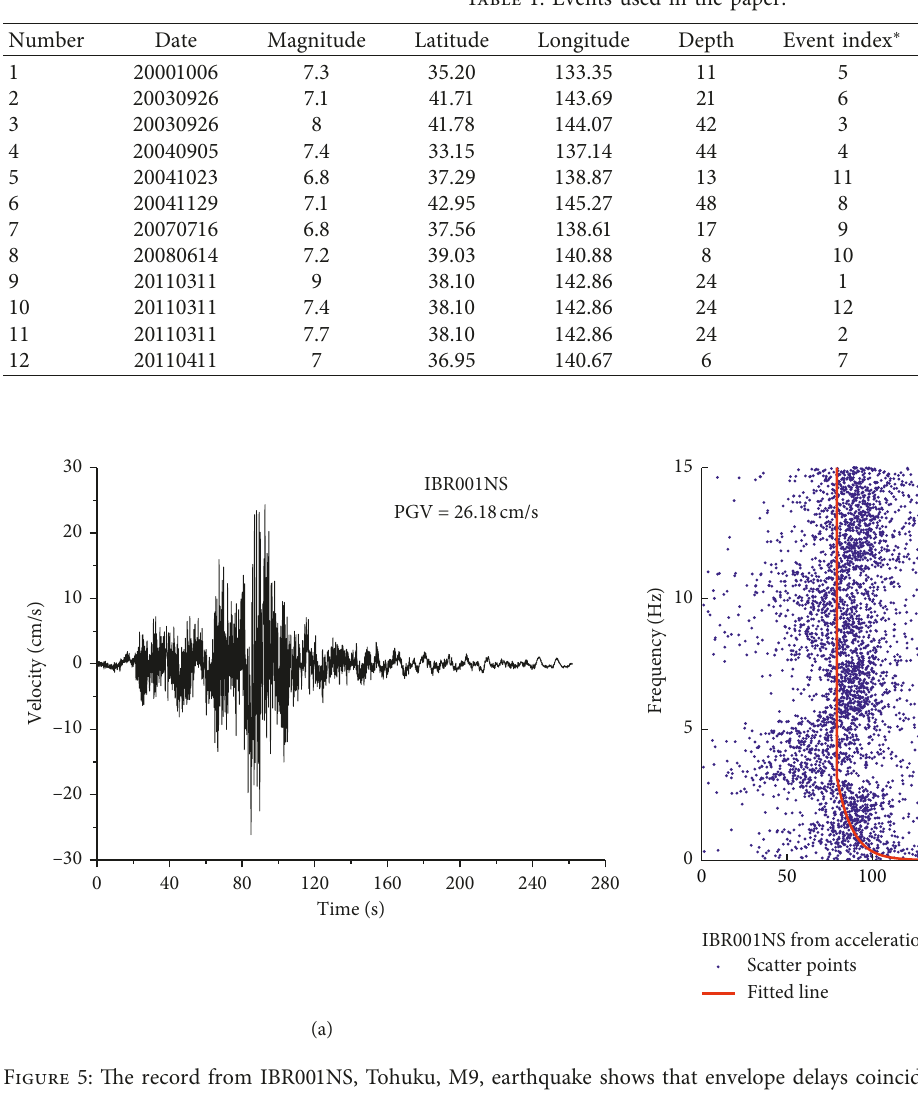
Table 1: Events used in the paper.